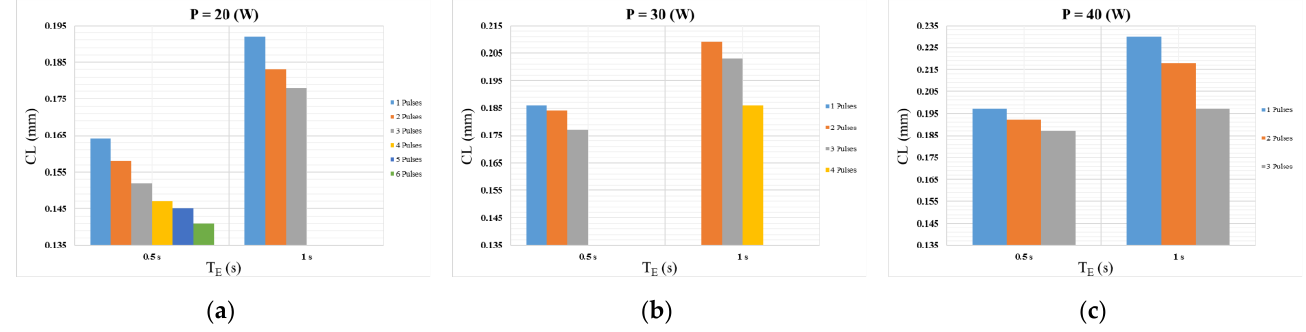
Figure 3. Influence of T E and N P on CL for 0.1 wt.% of CNPs and ( a ) P = 20 W, ( b ) P = 30 W and ( c ) P = 40 W.